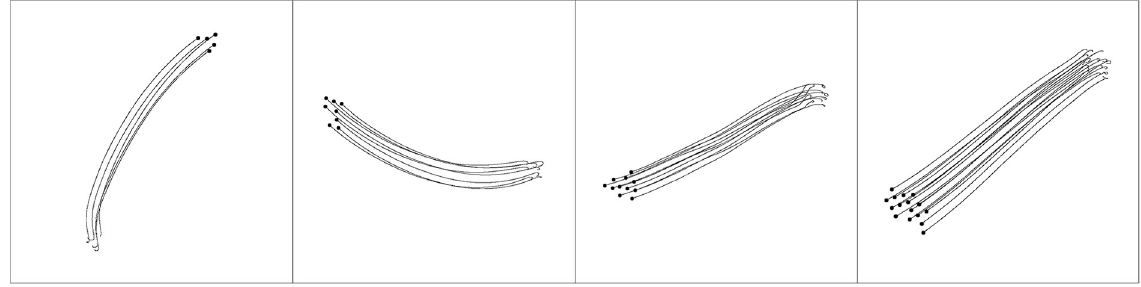
Fig 6. Example of the behaviour displayed by the highest-performing controller evolved in the Global setup , with 5, 8, 11 and 16 robots, from left to right. Observing the beginning of trajectory, we can see the robots evolved the strategy of making a quick turn around their initial positions, in order to first form an aligned group before moving